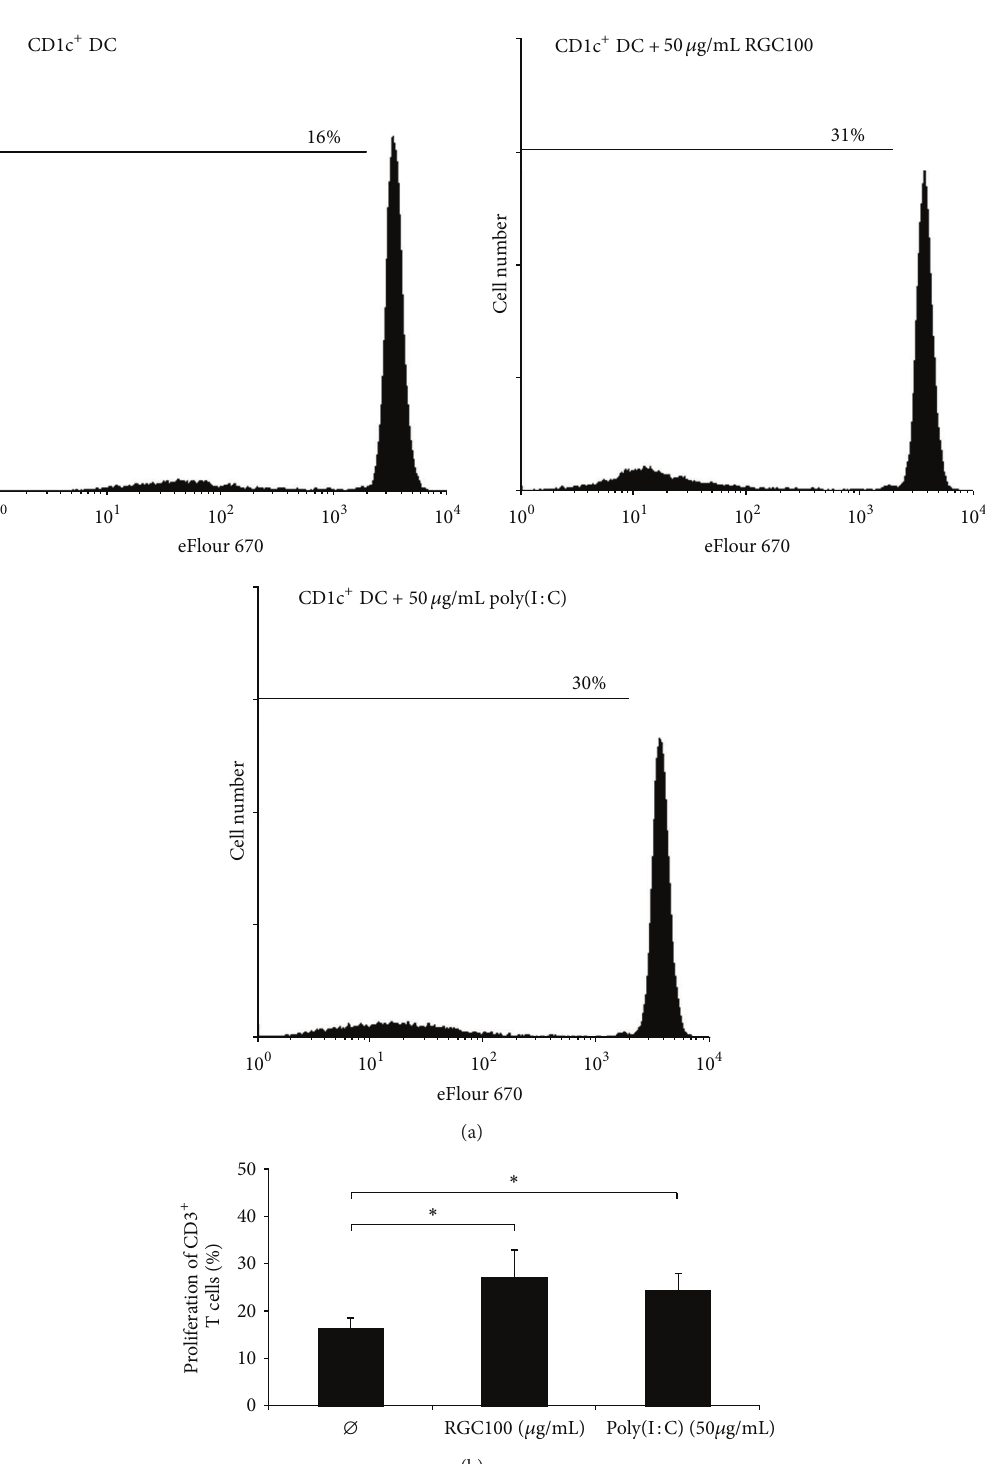
Figure 7: Impact of RGC100 and poly(I:C) on CD1c + DC-mediated T-cell proliferation. CD1c + DCs were cocultured with autologous T cells in the presence or absence of 50 𝜇 g/mL RGC100 or poly(I:C). Before coculture, T cells were stained with cell proliferation dye eFluor 670. Cells were incubated for 8 days and harvested and T cell proliferation was determined by flow cytometry. (a) The results of one representative donorout ofthreeperformedwith similarresultsaredepicted. (b)Theresultsofthreedifferentdonorsarepresented asmean ± SEM. Asterisks indicate a statistically significant difference ( ∗ 𝑃 < 0.05